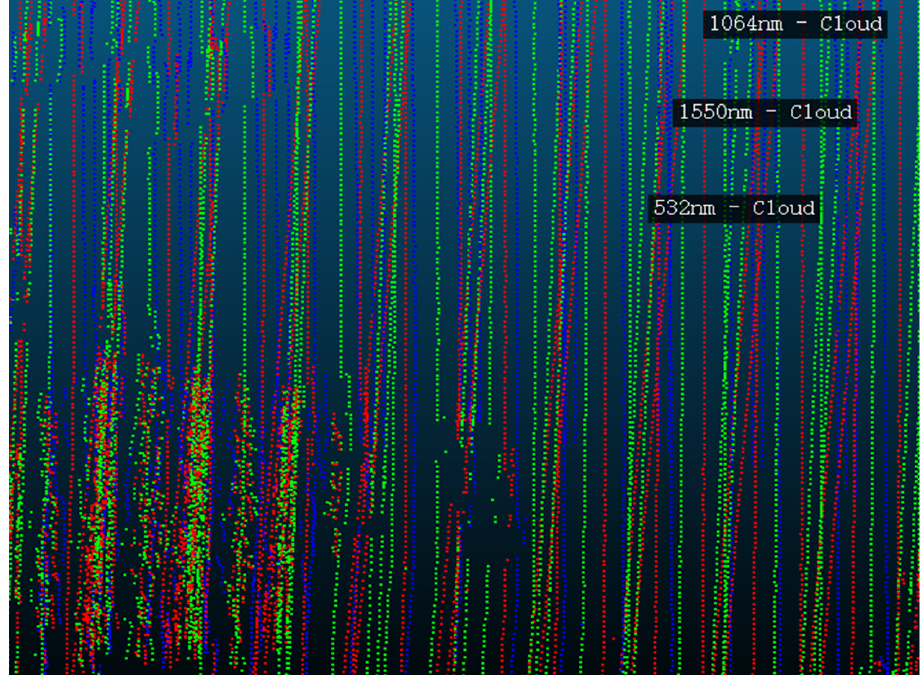
Figure 4. Single-wavelength point cloud with three different channels (the points of the 1550 nm channel are red, the points of the 1064 nm channel are green, and the points of the 532 nm channel are blue).